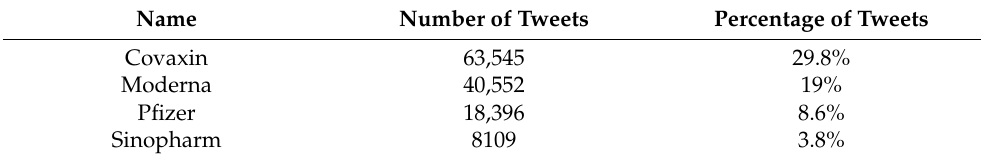
Table 1. The total number of tweets collected related to different COVID-19